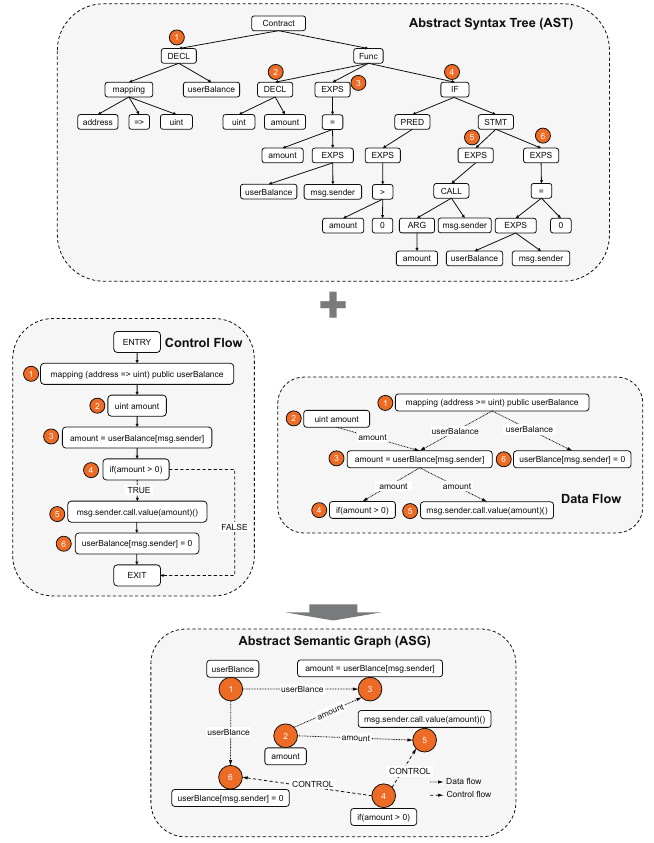
Figure 4. Abstract semantic graph generation based on abstract syntax tree and enriched by control flow and data